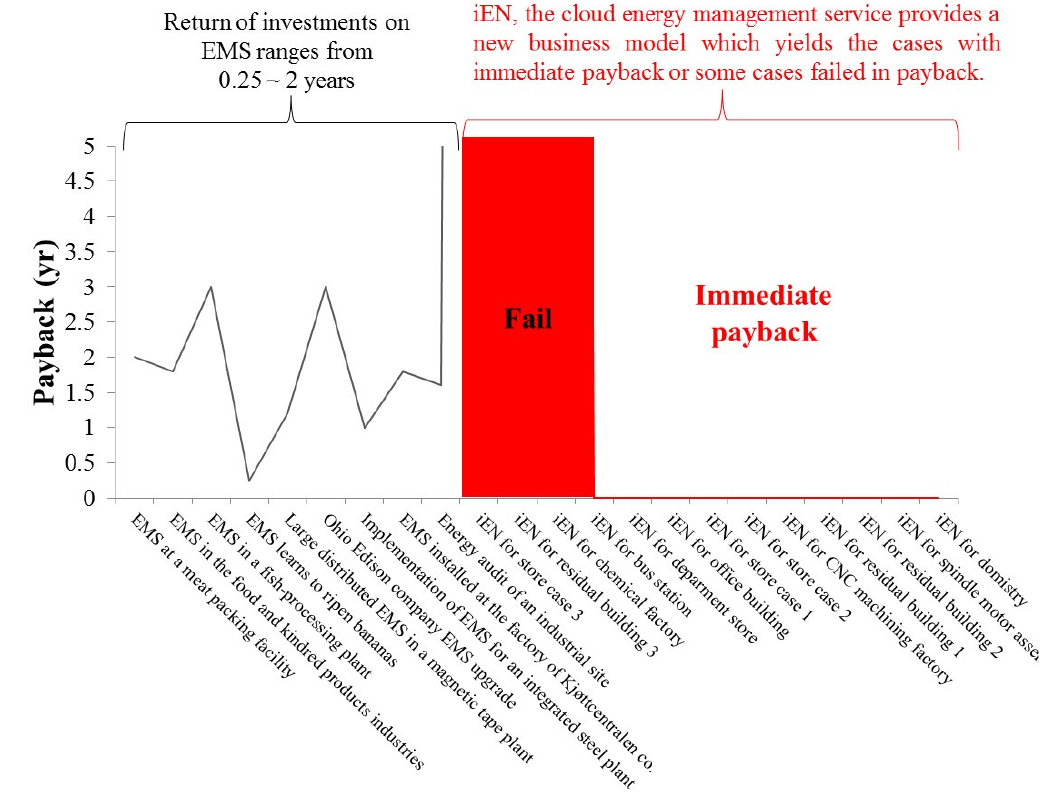
Figure 8. Payback period of investment by applying EMS and cloud EMS. The payback time of EMS is 0.25–2 years. However, the Cloud EMS, iEN, yields the cases with immediate payback or never payback (Fail cases as shown in Red